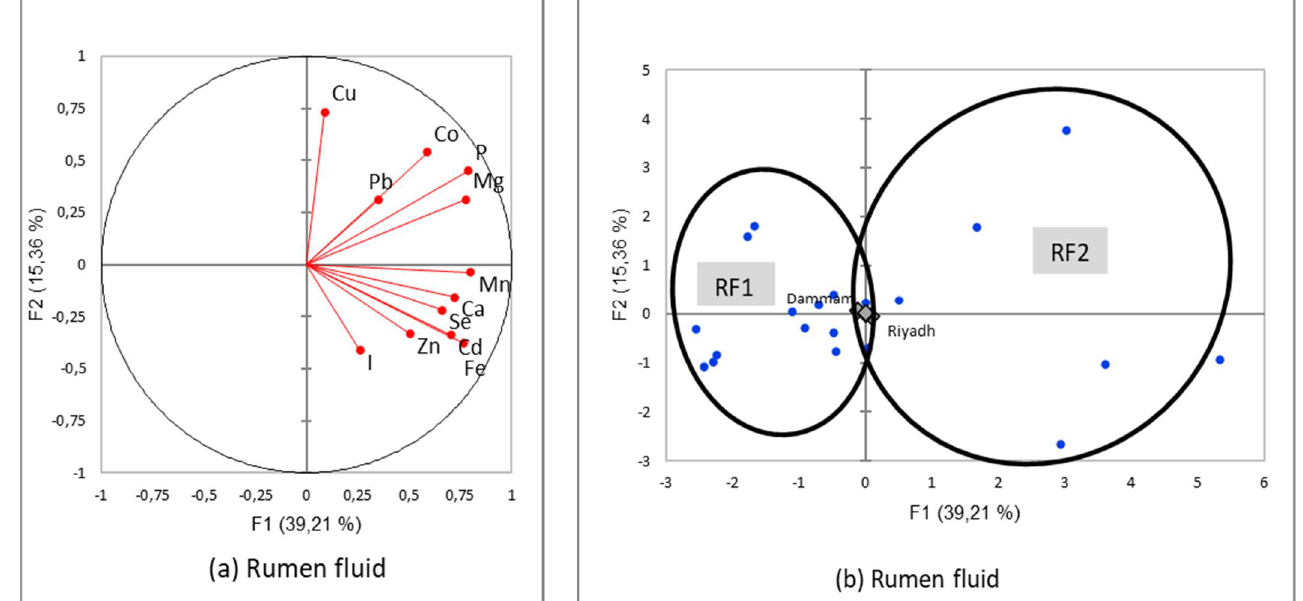
Figure 7. Correlation circles ( a ) for the two first factors of the Principal Components Analysis demonstrating the relationships between minerals in camel rumen fluid and the main factorial plan ( b ) with representation of the two mineral patterns of the rumen fluid sampled in two regions of Saudi slaughterhouses at two seasons (squares represents the mean value for each region and dots the different rumen fluid sample values). Table 13. Mean values of minerals in camel rumen fluid according to the patterns issued by Ascending Hierarchical Classification [µg/L].